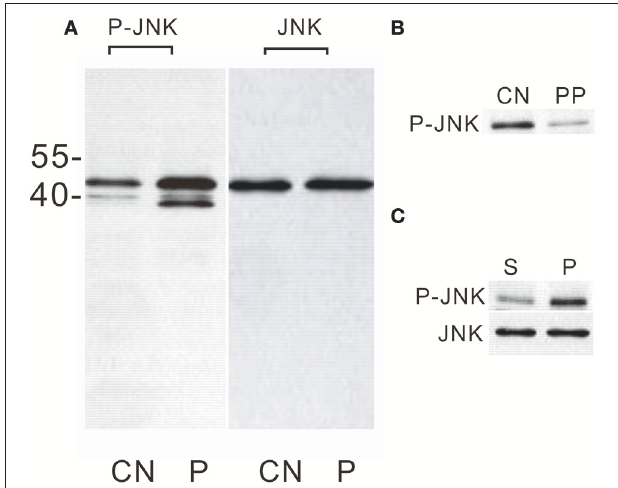
FIGURE 1 | Western blot analysis of JNK phosphorylation in Bombyx PGs. (A) Effect of the PTTH in vitro . PGs were pre-incubated in control medium for 30min and then transferred to control medium (CN) or medium containing the PTTH (P). PGs were incubated for 1h. MW markers are shown on the left side of the gel. (B) Effect of lambda protein phosphatase treatment. CN, treated with buffer only; PP, treated with lambda protein phosphatase. (C) Effects of an in vivo PTTH injection on JNK phosphorylation. Larvae from day-6 last instar were injected with saline containing the PTTH (P) or saline only (S). At 30min after the injection, PGs were quickly dissected out, and then immediately flash-frozen. Gland lysates were prepared and subjected to an immunoblot analysis with anti-phospho-JNK (P-JNK) and anti-JNK (JNK) antibodies. Results shown are representative of three independent